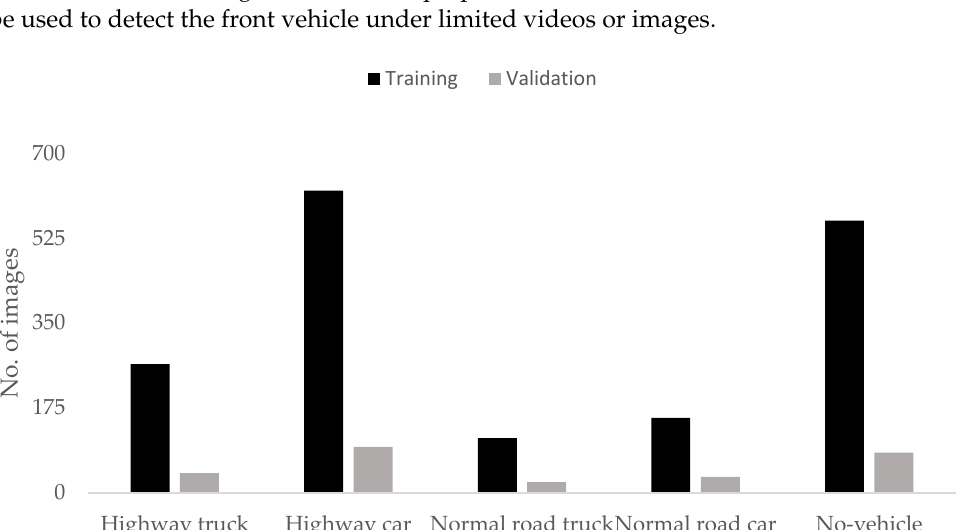
Figure 5. An example of the trapezoid area.